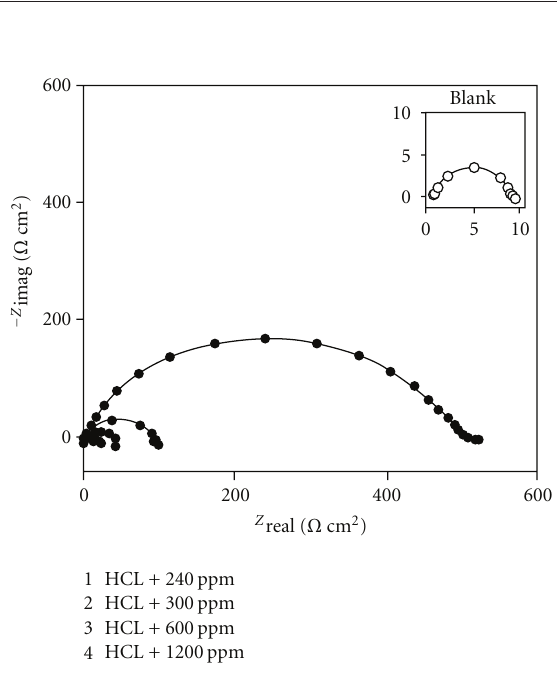
Figure 3: Nyquist plots in absence and presence of di ff erent concentrations of extract in1M HCl.